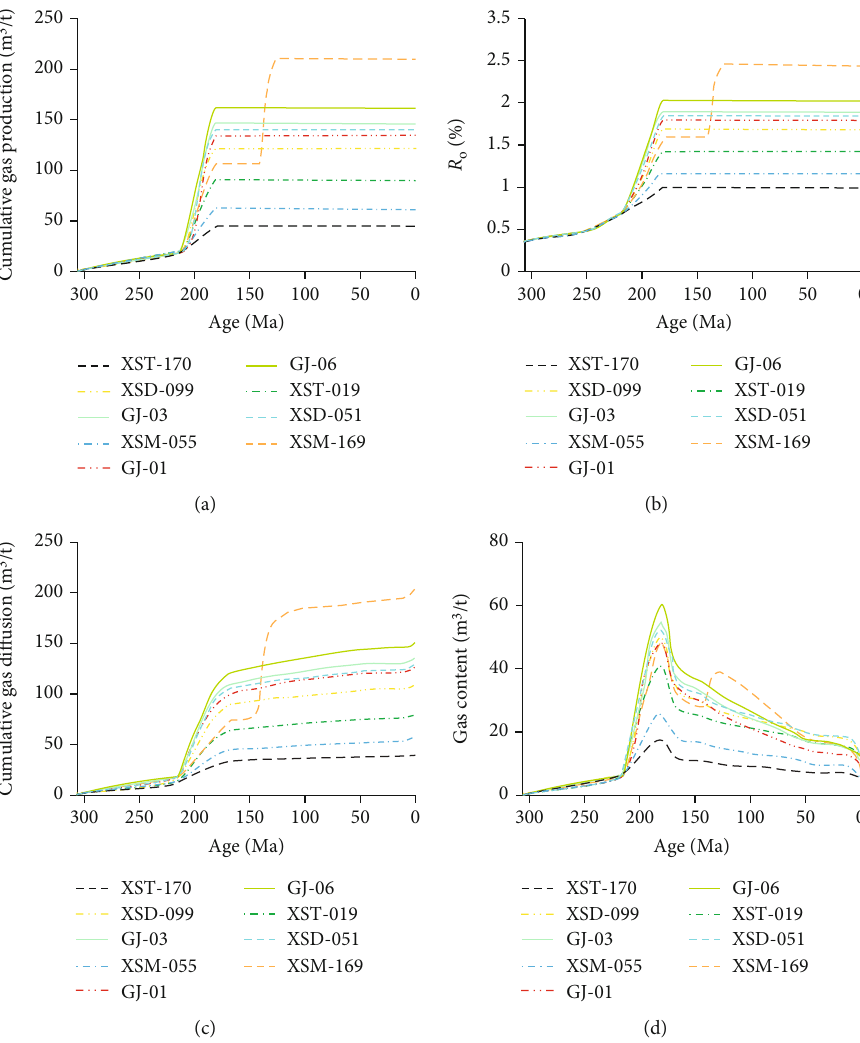
Figure 8: Curves show the CBM reservoir formation evolution history: (a) cumulative gas generation; (b) coal organic maturity; (c) cumulative gas di ff usion; (d) gas